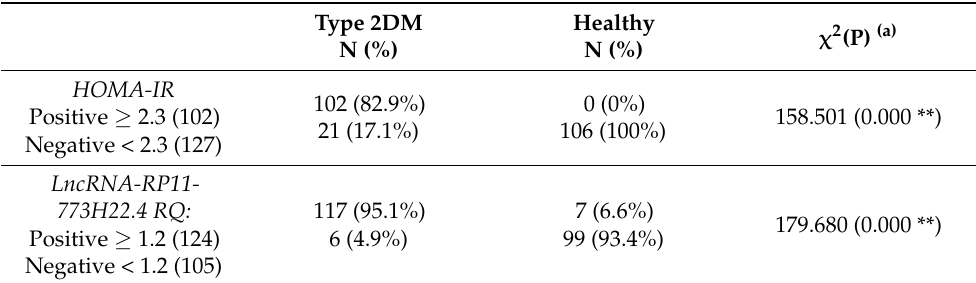
Table 2. Positivity rate of HOMA-IR and the investigated candidate genes in the investigated groups according to the calculated cutoff ( n =